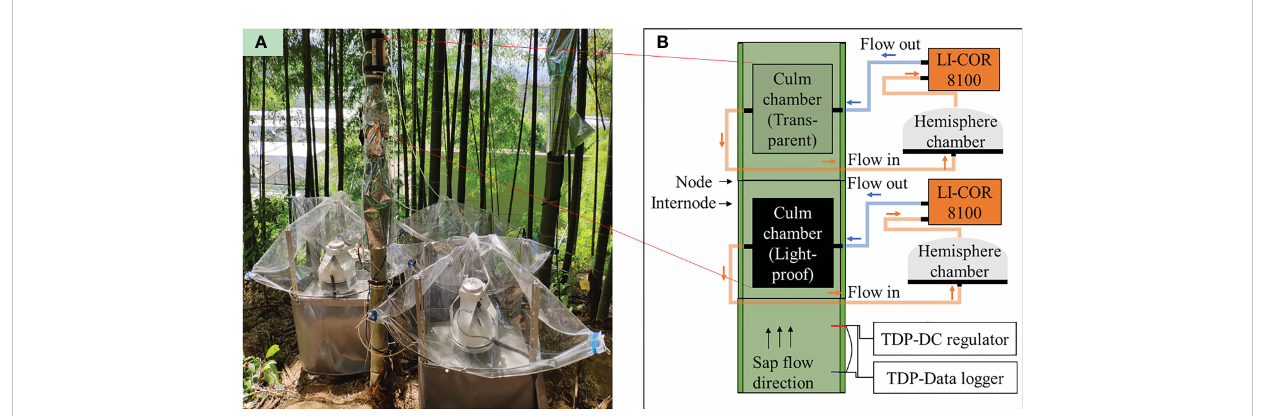
FIGURE 2 (A) Field installation and (B) schematic presentation of the equipment for monitoring CO 2 ef fl ux ( E s , m mol m − 2 s − 1 ) in the fi eld. The black and grey areas on the culm refer to light-proof and transparent culm chambers (double-chamber method). Each culm chamber was connected to an LI-Cor 8100 and a sealed hemisphere chamber. A pair of TDP was placed on an internode below the light-proof culm chamber. The sap fl ow direction was almost upward in the